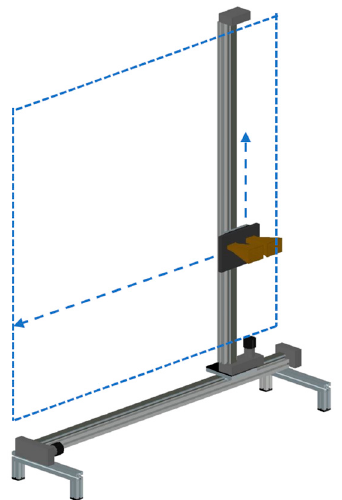
Figure 18. GBSAR with 3D imaging capability.